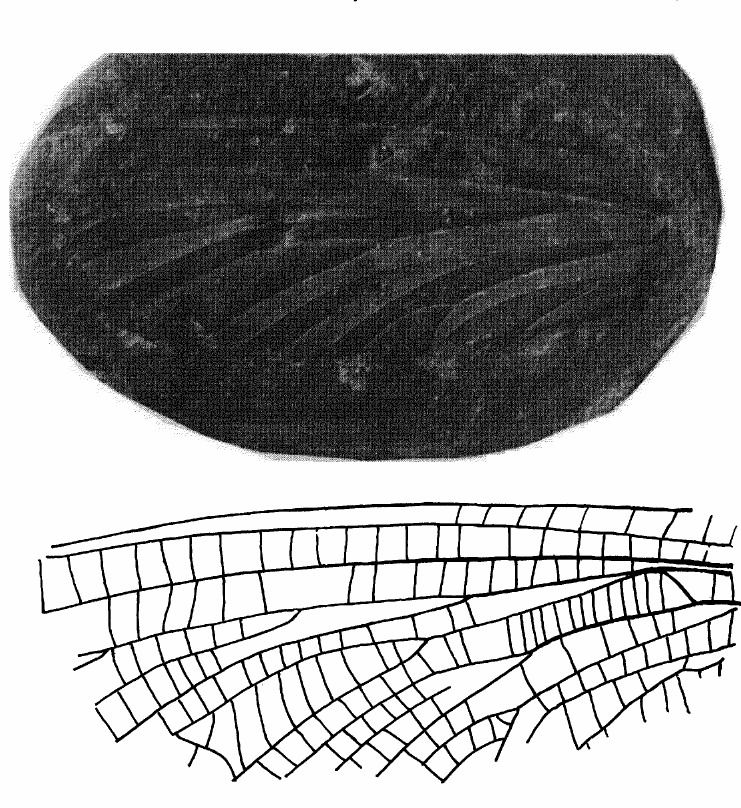
Fig. 8. Lithoneura carpenteri Richardson, fore wing. Holotype, No. 45248, Walker Museum, University of Chicago. Length of fragment, 55 mm. Upper figure, photograph of type; lower figure, venational